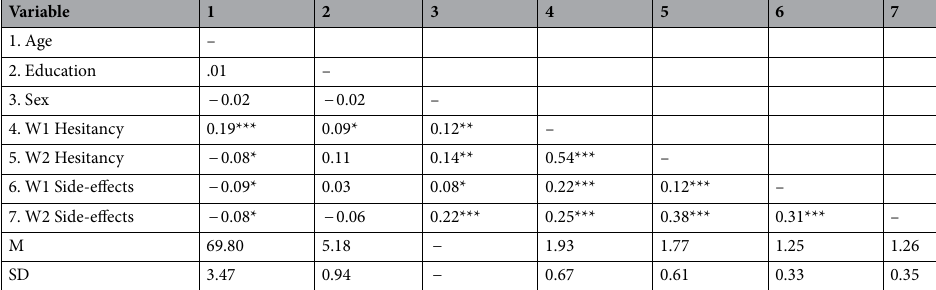
Table 1. Means, Standard Deviations, and Intercorrelations Between Main Study Measures. N = 756, * p < 0.05, * * p < 0.01, * * * p < 0.001. All correlations are Pearson, except for Sex which is point bi-serial.